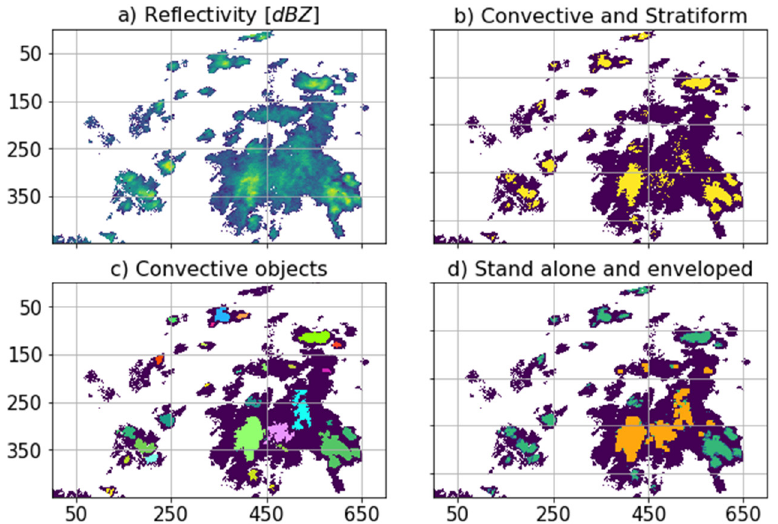
Figure 3. Example of a classified radar image. ( a ) Original reflectivity image in dBZ, ( b ) identification of convective (yellow) and stratiform systems (purple), ( c ) ID assignation to each convective system, and ( d ) identification of enveloped (orange) and unenveloped (green) systems.